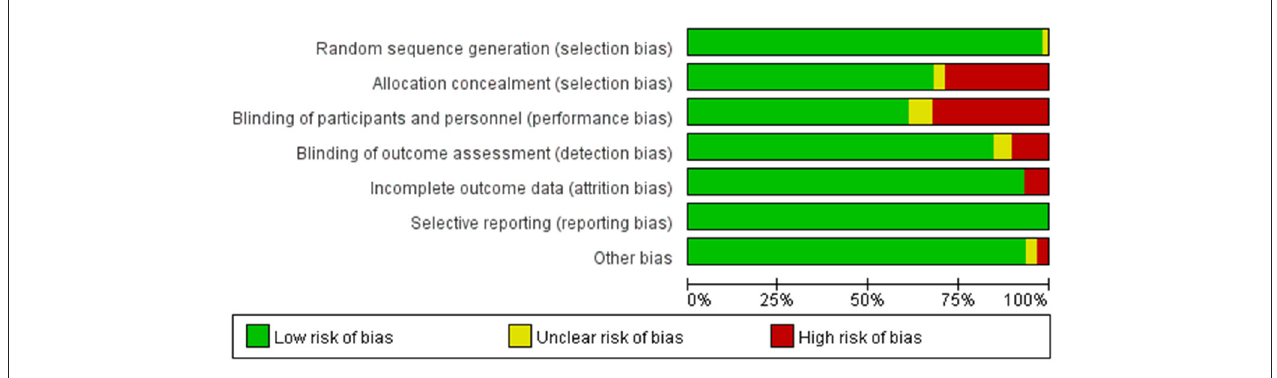
FIGURE 4 | Risk of bias graph: review judgments of authors about each risk of bias item presented as percentages across all included studies.